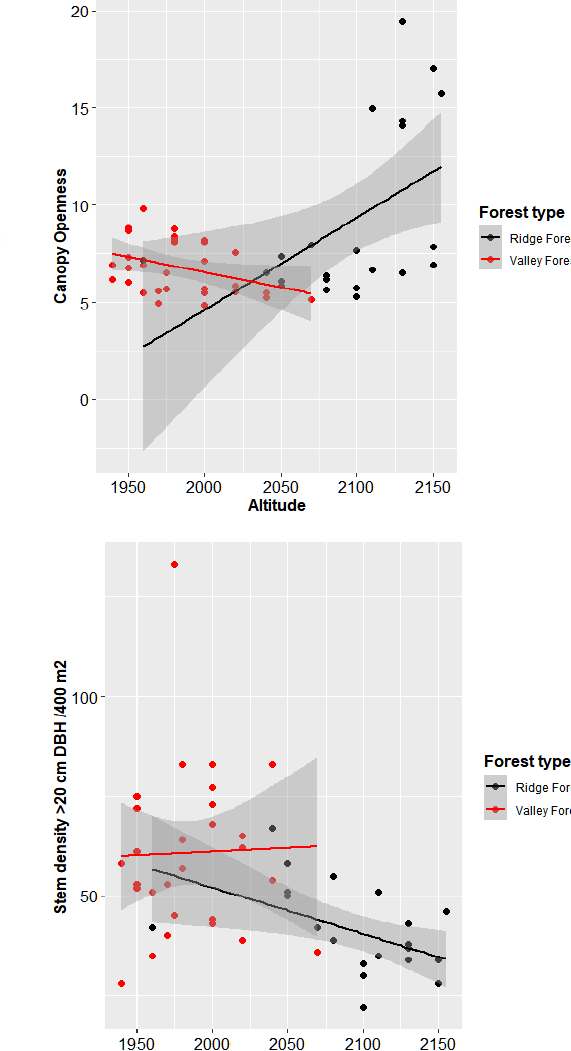
Figure 3. Biplot showing the ordination of 52 sample plots, points show the grouping and the vec- tors indicate the variables that mostly influenced the